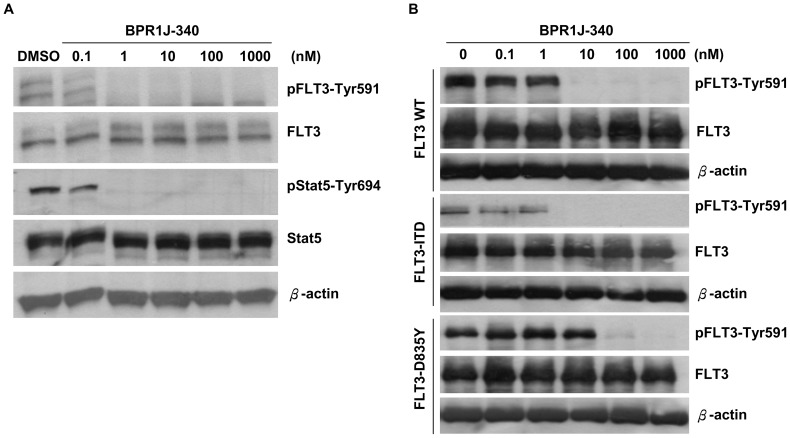
BPR1J-340 inhibits FLT3-dependent signaling.(A) MV4;11 cells were treated with BPR1J-340 at the indicated concentrations for 1 hour. The phosphorylation status of FLT3 and STAT5 were evaluated by Western blot analysis. (B) HEK 293T cells were transfected with FLT3-WT-, FLT3-ITD-, or FLT3-D835Y-expressing plasmids for 24 hours and then incubated with various concentrations of BPR1J-340 for 1 hour. The FLT3 phosphorylation status in the transfected cells was evaluated by Western blot analysis.